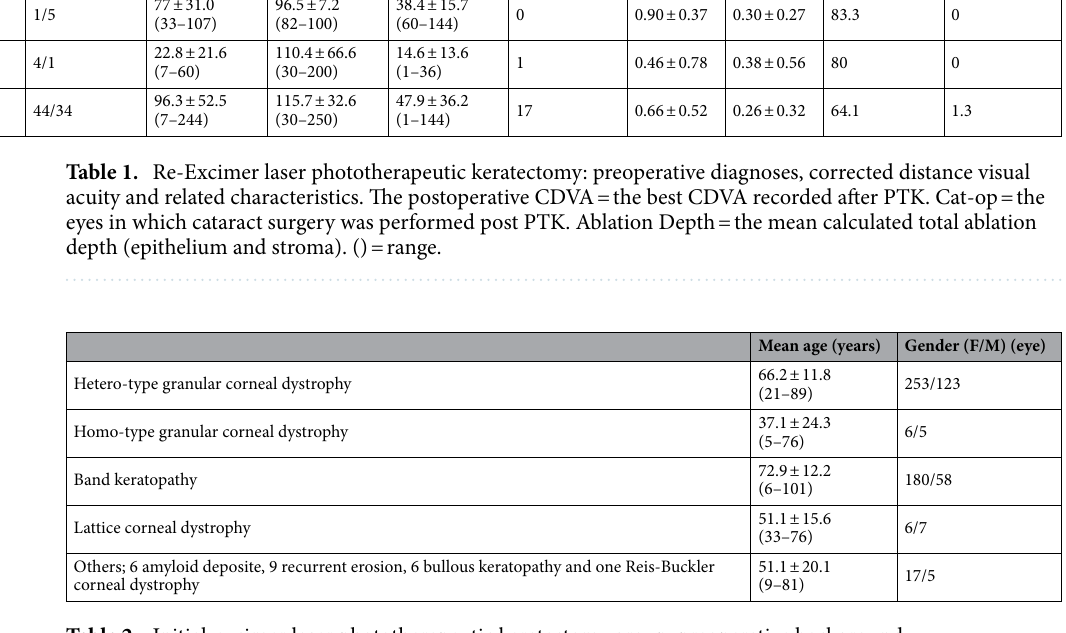
Table 2. Initial-excimer laser phototherapeutic keratectomy group: preoperative